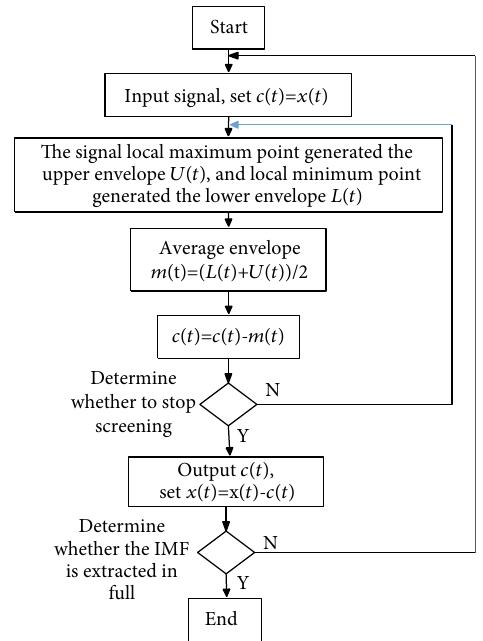
Figure 1: EMD method for screening